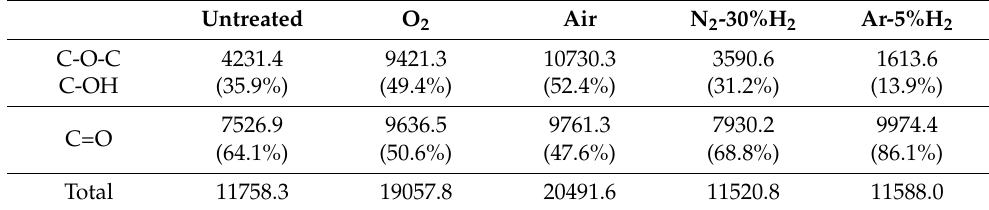
Table 4. Intensity ratios of signals in the XPS O 1s narrow spectra.